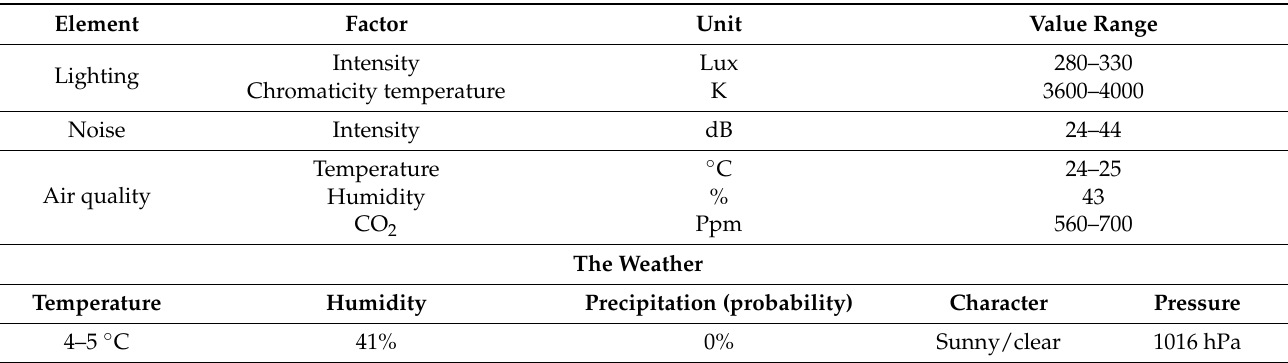
Table 1. Controlled environmental and weather